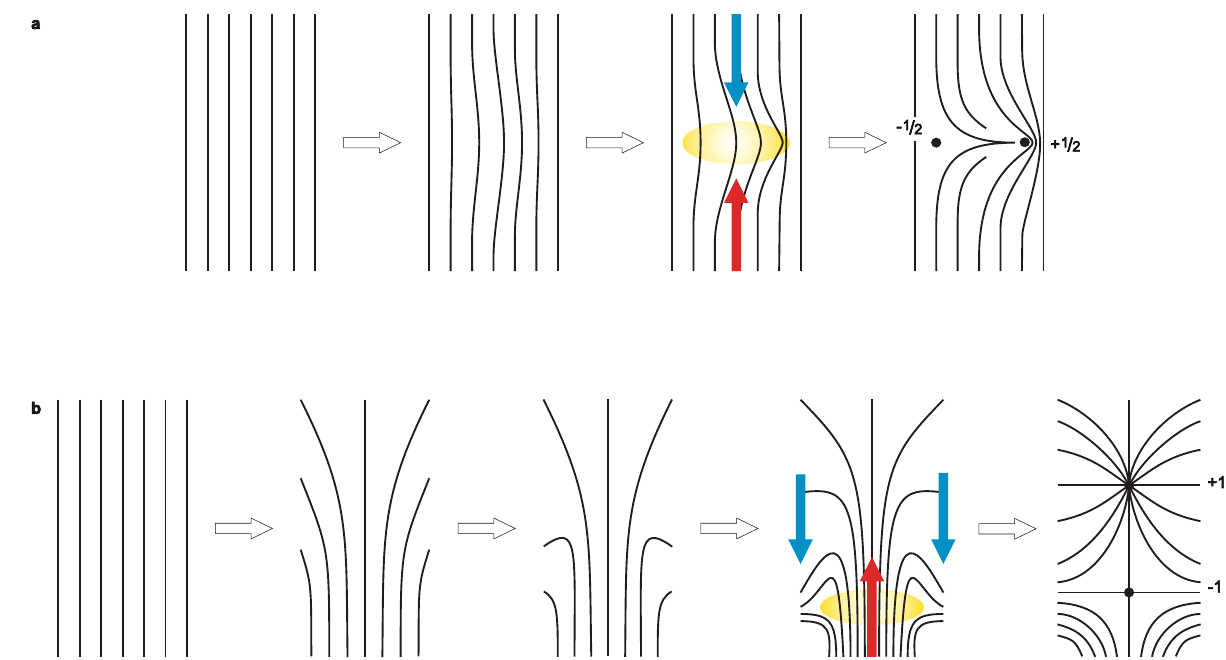
Fig. 9 | Productionoftopological defectsin 2Dactive nematic and in our layer ofdrivennematic liquidcrystal(LC).a In theactivenematicLC apair of − 1/2and +1/2 topological defects is created by the self-amplifying bend instability. The instabilityemergesfromabend fl uctuationintheyellowarea,whichisampli fi edby the activityandatsome instant gets relievedbythe formation of the defectpairof opposite half-integer winding. b In driven nematic LC, the counter-rotating fl ow vortices give rise to self-amplifying splay distortion. The counter propagating fl ow